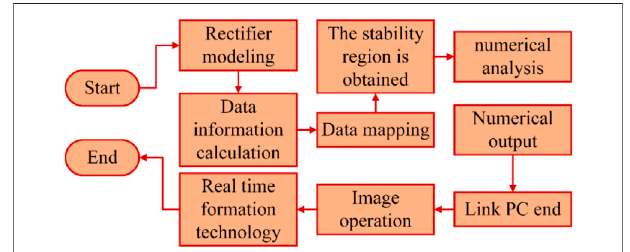
FIGURE 3 | Control fl ow chart of the